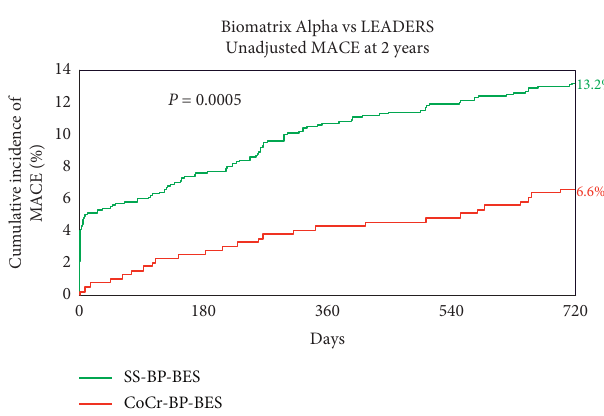
Figure 1: Unadjusted MACE at 2 years. CoCr-BP-BES � cobalt- chromium biodegradable polymer Biolimus A9-eluting stent, MACE � major cardiac adverse events, and SS-BP-BES �